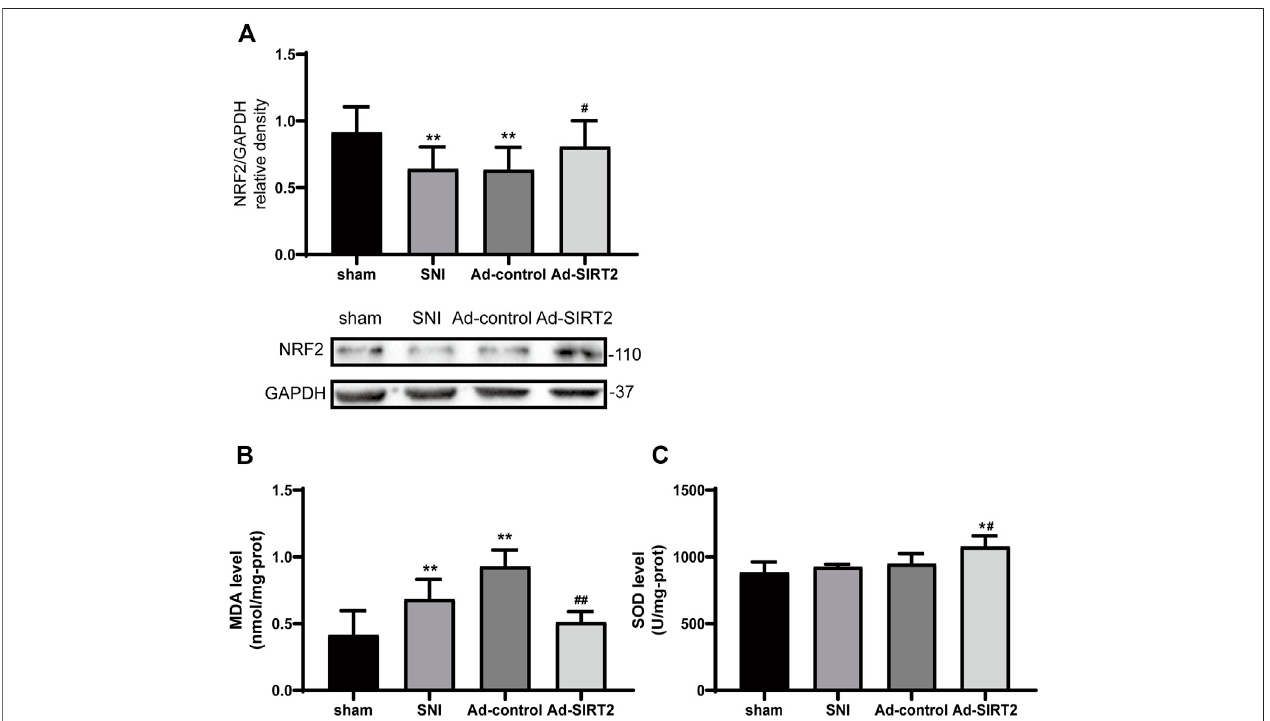
FIGURE 5 | Intrathecal injection of SIRT2 decreases lipid peroxidation in the spinal cord of SNI rats. (A) Changes to NRF2 expression in the spinal cord after an intrathecal injection of Ad-SIRT2 or Ad-control. The rats in the sham operation group were used as controls. Changes to MDA (B) and SOD (C) expression in the spinal cord afteranintrathecalinjectionofAd-SIRT2orAd-control.Theratsintheshamoperationwereused asthecontrolgroup.Valuesareexpressed asthemean±SE( n = 5 per group). * p -values of < 0.05 and ** p -values of < 0.01 for comparisons with sham rats or baseline values of the SNI rats (day 0); # p -values of < 0.01 and ## p -values of < 0.01 for comparisons with SNI or Ad-control rats. SNI, spared nerve injury; SIRT2, sirtuin 2; NRF2, nuclear factor erythroid 2-related factor 2; MDA, malondialdehyde; SOD, antioxidant enzyme superoxide